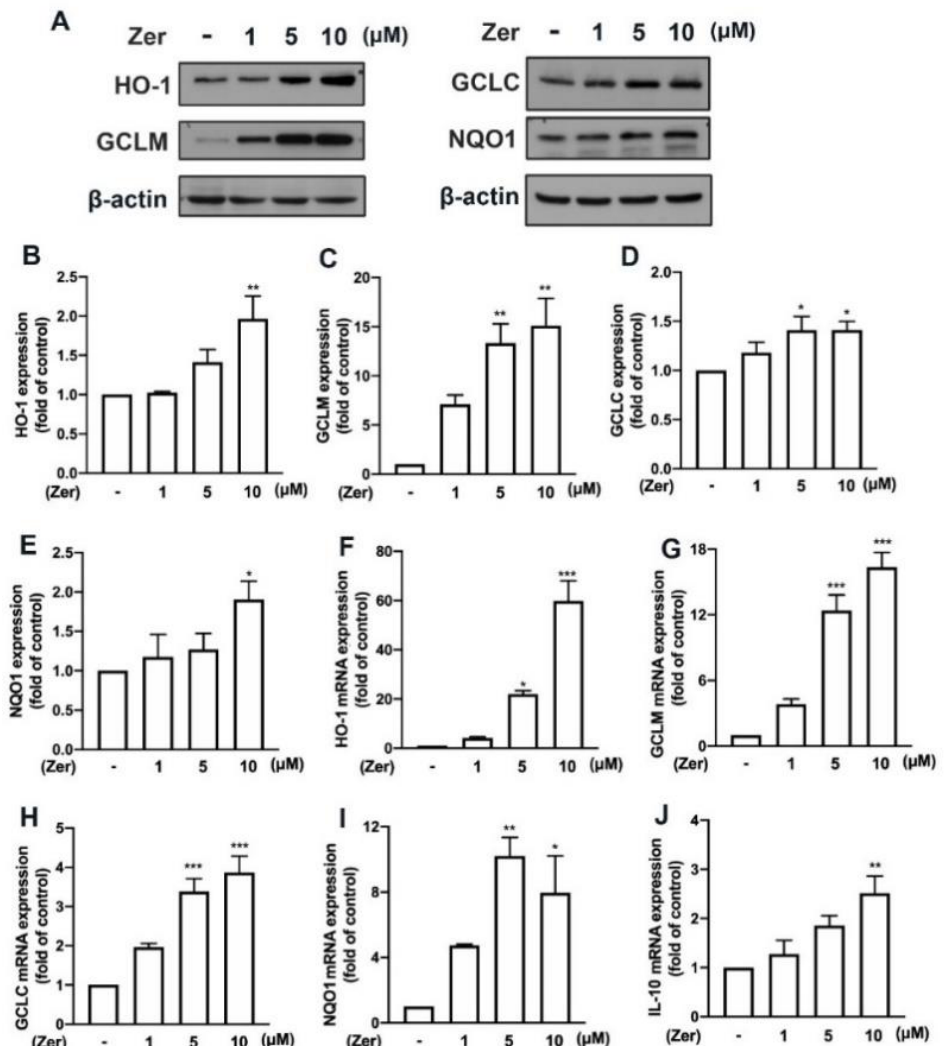
Figure 7. The expression of endogenous antioxidants and anti-inflammatory cytokines in response to zerumbone in microglia. ( A ) Different concentrations of zerumbone (1, 5, or 10 µ M) were supple- mented on IMG cells for 24 h. Protein expressions of HO-1, GCLM, GCLC, and NQO1 were evaluated using Western blotting. The quantitative results of HO-1 ( B ), GCLM ( C ), GCLC ( D ), and NQO1 ( E ) were determined by using ImageJ. Different concentrations of zerumbone (1, 5, or 10 µ M) were supplemented on IMG cells for 6 h. HO-1 ( F ), GCLM ( G ), GCLC ( H ), NQO1 ( I ), and IL-10 ( J ) mRNA expressions were quantified using real-time PCR. Each bar represents the mean ± SEM ( n = 3 or 4). * p < 0.05, ** p < 0.01, *** p < 0.001 compared with the control group.